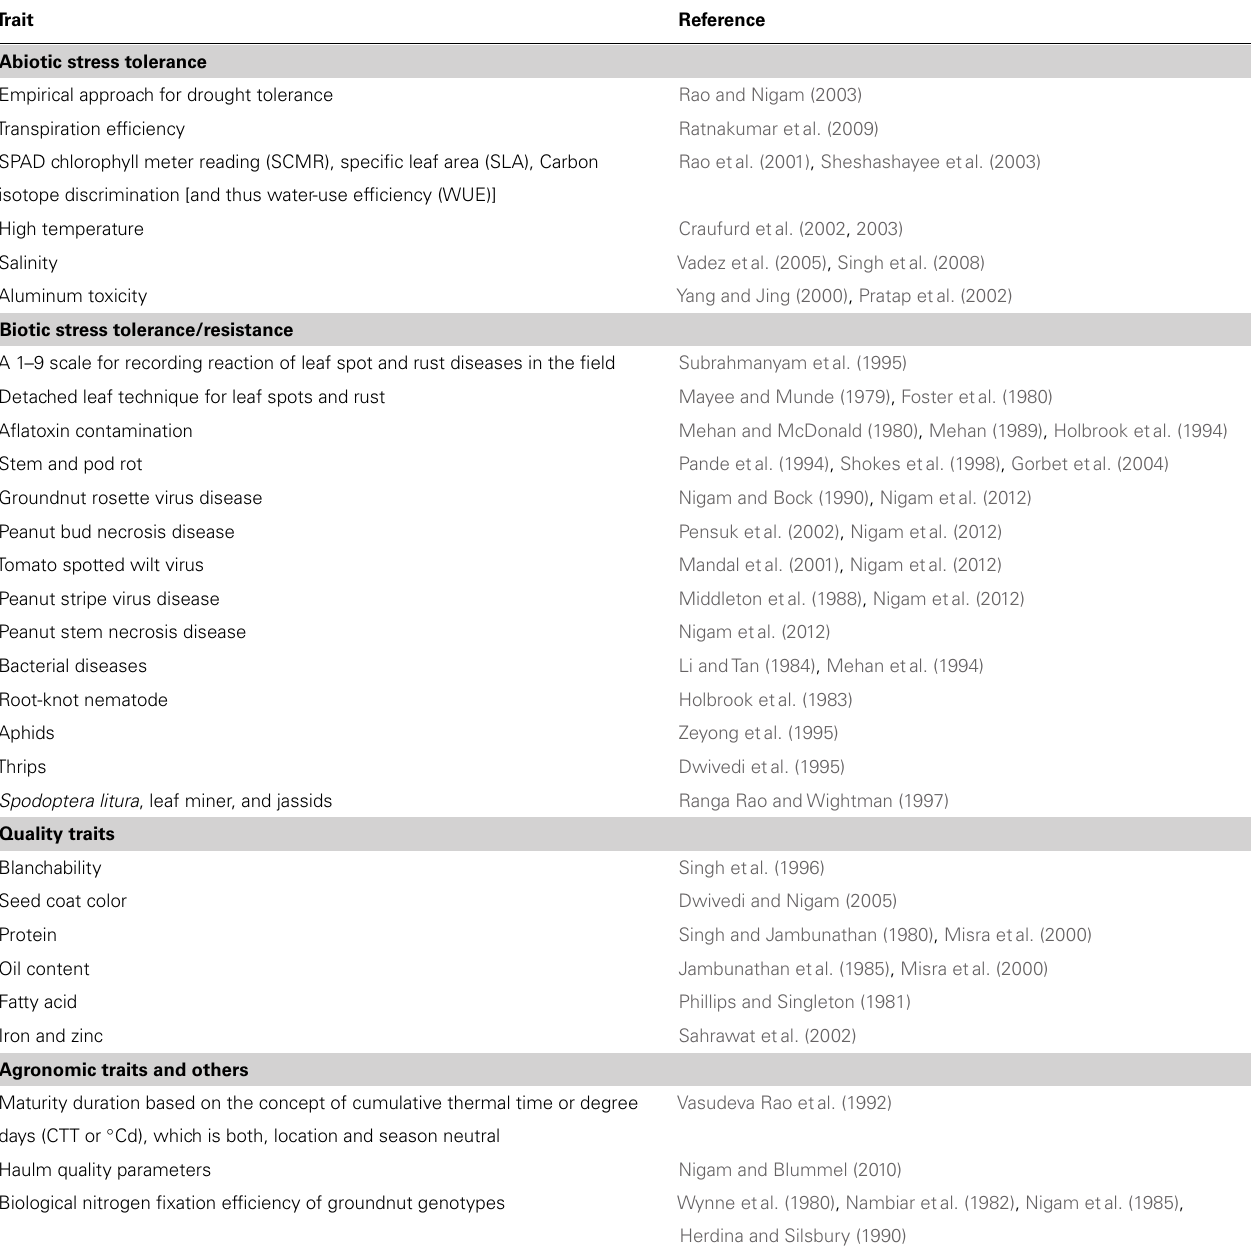
Table 2 | Groundnut traits for which phenotyping methods are described in the